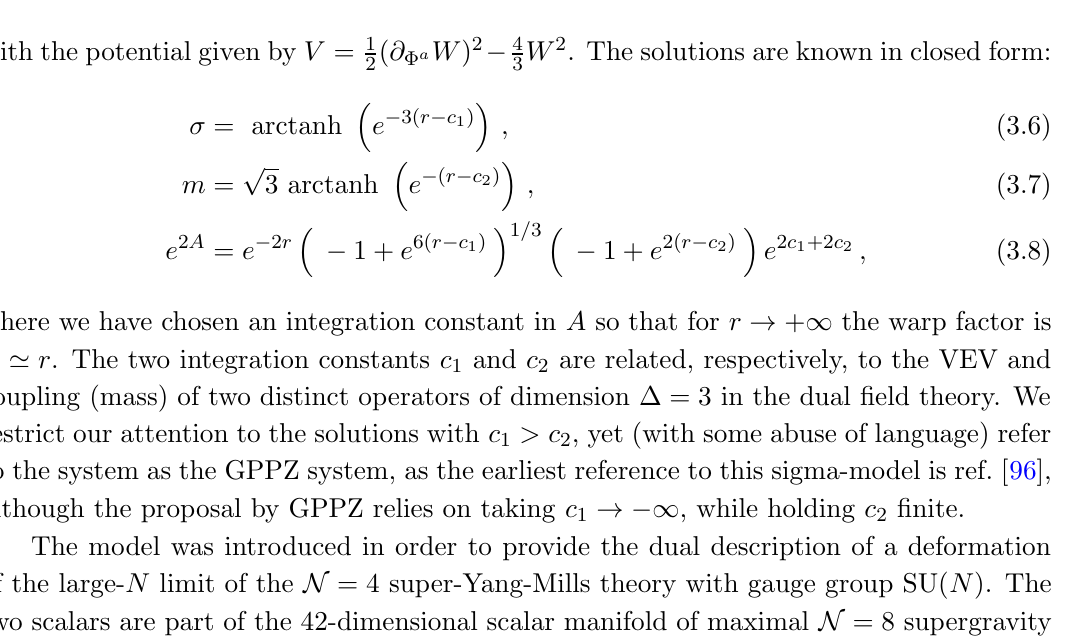
p Figure 2 . Masses M = (cid:0) q 2 of modes in the GW system, for (cid:1) = 2 : 5, r 1 = 0, r 2 = 6, and a 0 = 0, as a function of the integration constant (cid:8) 1 . All masses are expressed in units of the mass of the lightest tensor mode. The (red) squares represent the tensor modes, the (blue) disks are the scalar modes, computed with the complete, gauge-invariant variables, while the (black) triangles are the scalar modes computed by making use of the probe